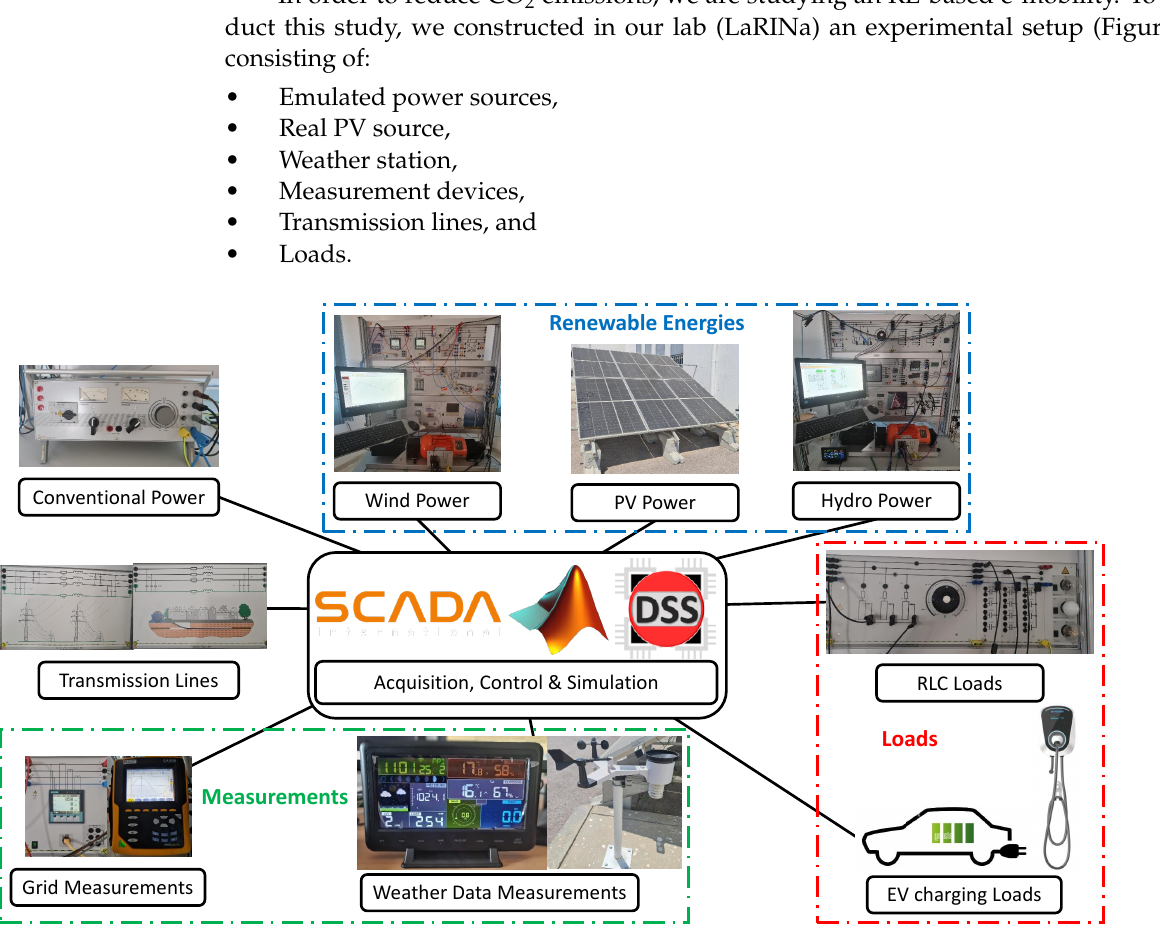
Figure 1. Available materials and